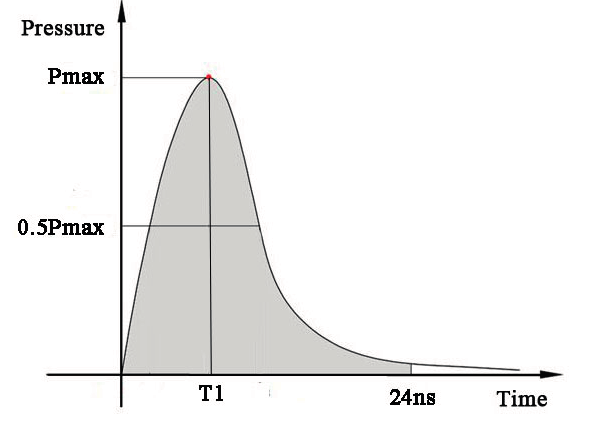
Figure 11. The curve of load versus